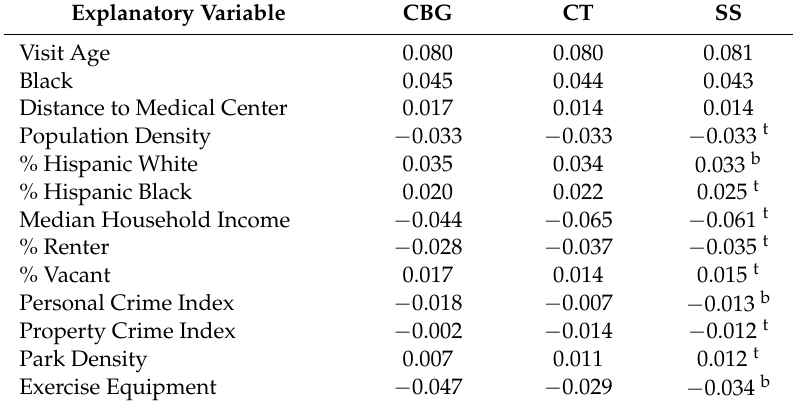
Table 7. OLS coefficient estimates for three models based on covariates that were selected by the spatial scale (SS) LARS/lasso model of BMI z-score: (1) when constraining all selected area-level covariates to enter at the CBG level; (2) when constraining all selected area-level covariates to enter at the CT level; and (3) when allowing all selected area-level covariates to enter at the model-selected spatial scale. The horizontal dashed line separates the individual-level variables and the area-level